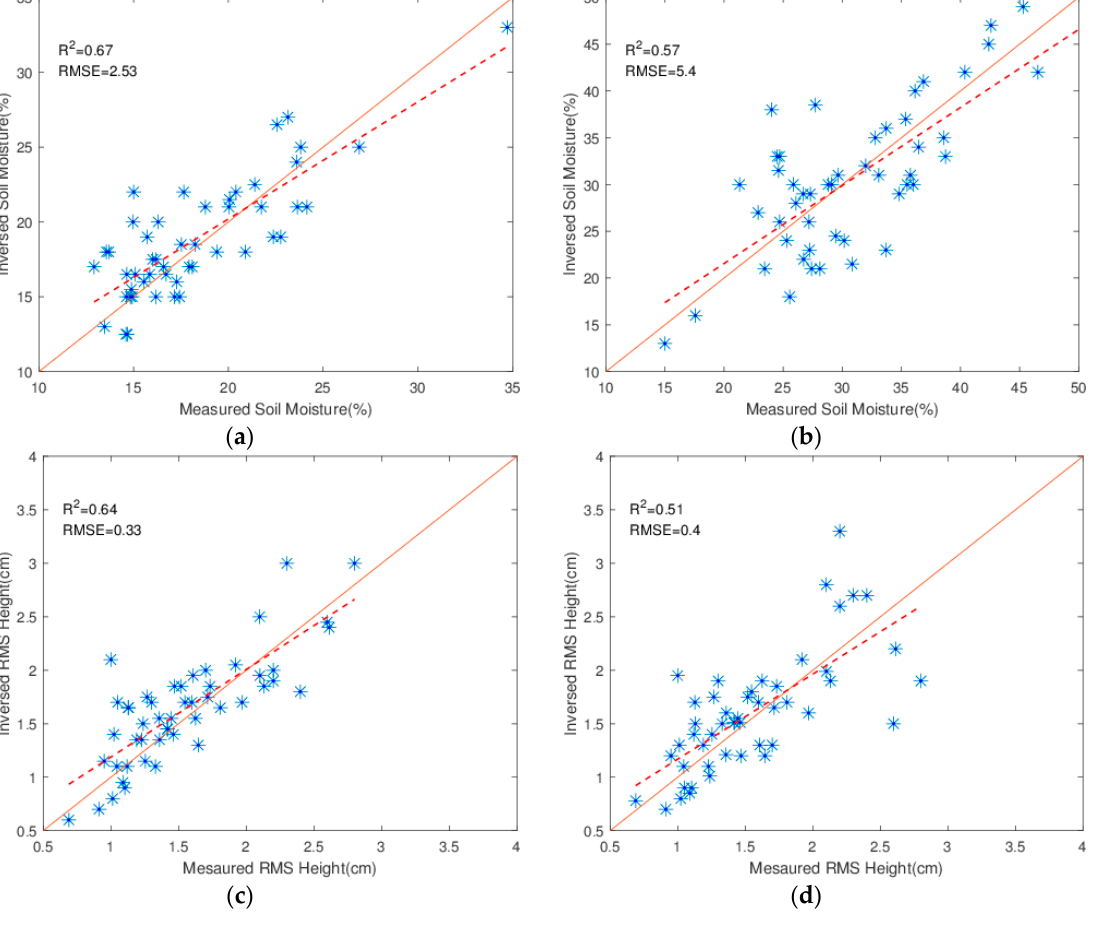
Figure 6. Comparison between inverted and ground-measured soil moisture and Hrms : ( a ) soil moisture, θ = 33.5°; ( b ) soil moisture, θ = 26.3°; ( c ) Hrms , θ = 33.5°; ( d ) Hrms , θ = 26.3°.